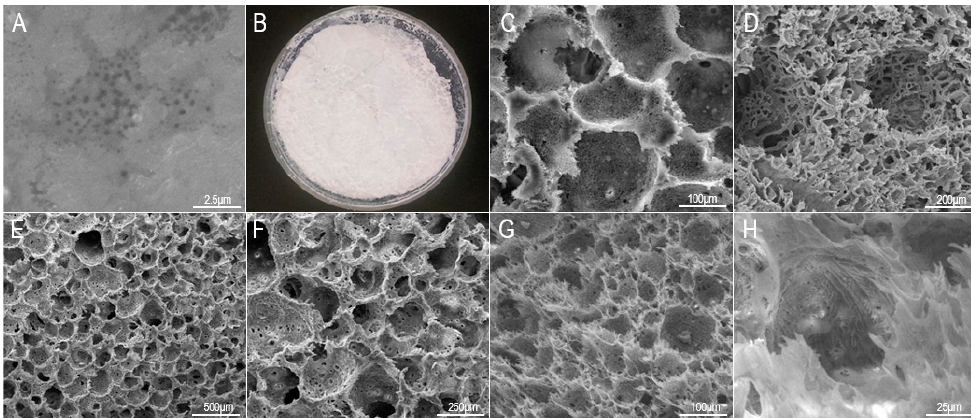
Figure 4. Characterization of HAAM and compound scaffolds. ( A ) HAAM under SEM; ( B ) Macro- scopic morphology of HAAM after freeze drying; ( C , D ) 6%, 12% PLA scaffolds, ( E , F ) 6% PLA +3% nHAp scaffolds and ( G , H ) 6% PLA +3% nHAp +2% HAAM scaffold under SEM.